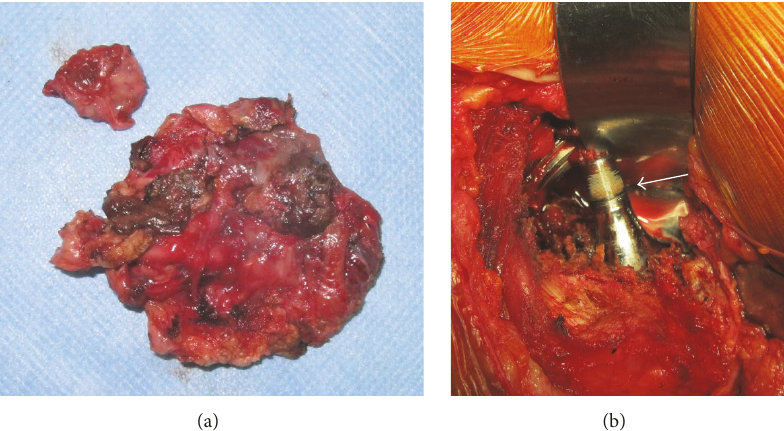
Figure 2: (a) Photograph of the resected pseudotumor. (b) Intraoperative photograph of the stem trunnion showing corrosion of the head- neck junction with black debris adhered to the trunnion (white arrow).